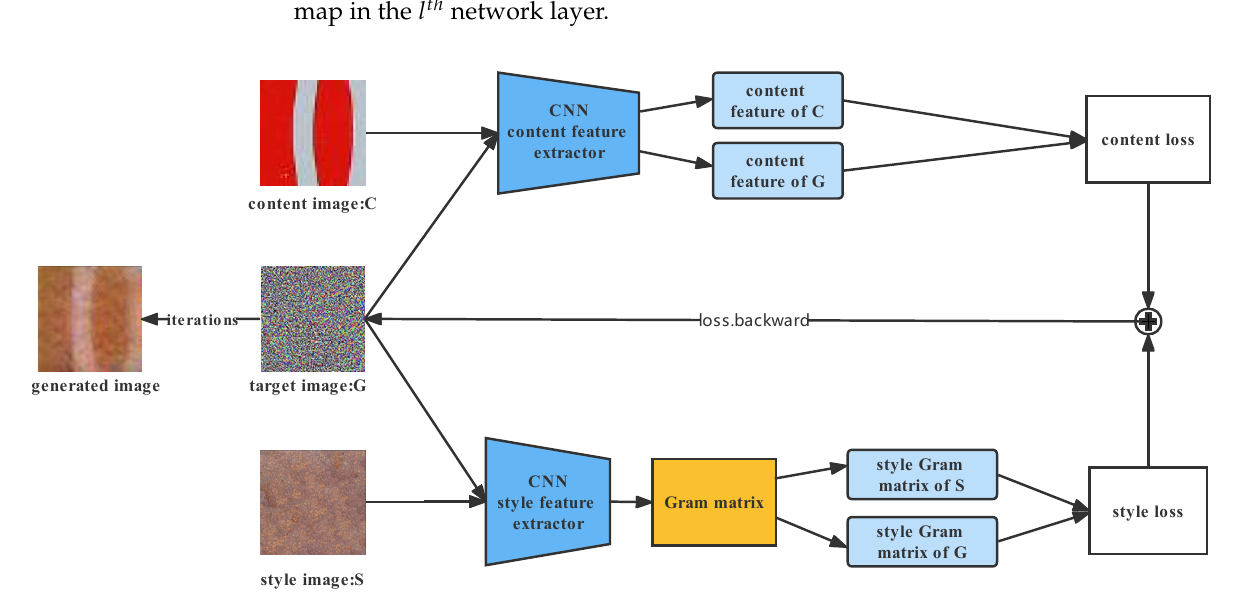
Figure 4. The overview of style